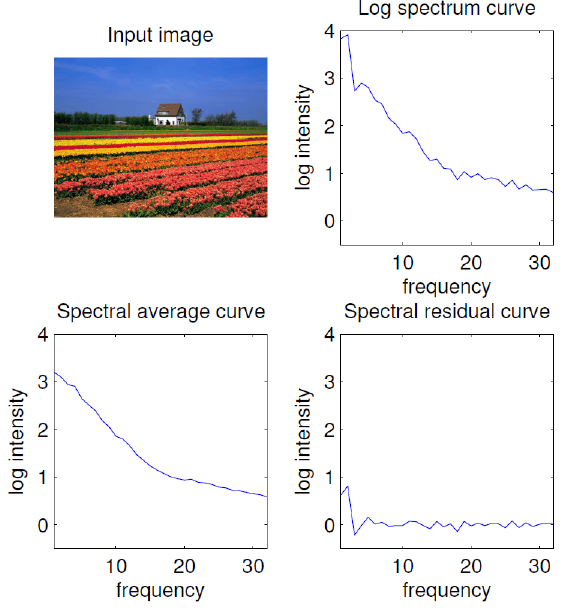
Figure 5. Average power spectrum trend in natural images (taken from Reference